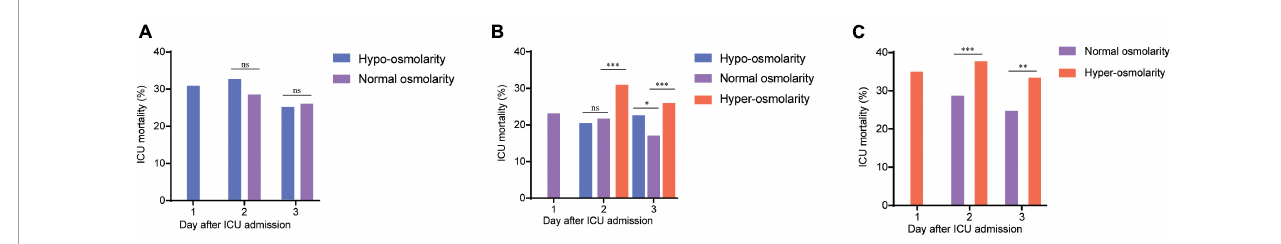
FIGURE2 The dynamics of mortality and serum osmolarity within 3 days after ICU admission. (A) The dynamical ICU mortality of the patients with hypo-osmolarity at admission who transformed into the normal osmolarity state on days 2 and 3. (B) The dynamical ICU mortality of the patients with normal osmolarity at admission who transformed into the hypo-osmolarity or hyper-osmolarity states or maintained the normal osmolarity state on days 2 and 3. (C) The dynamical ICU mortality of the patients with hyper-osmolarity at admission who transformed into the normal osmolarity state on days 2 and 3. The changes in the mortality of patients in the hypo-osmolarity group who transformed into the hyper-osmolarity state and those in the hyper-osmolarity group who transformed into the hypo-osmolarity state are not presented as these results are in single digits; this could result in statistical bias. ns p > 0.05; ∗ p < 0.05; ∗∗ p < 0.01; and ∗∗∗ p <